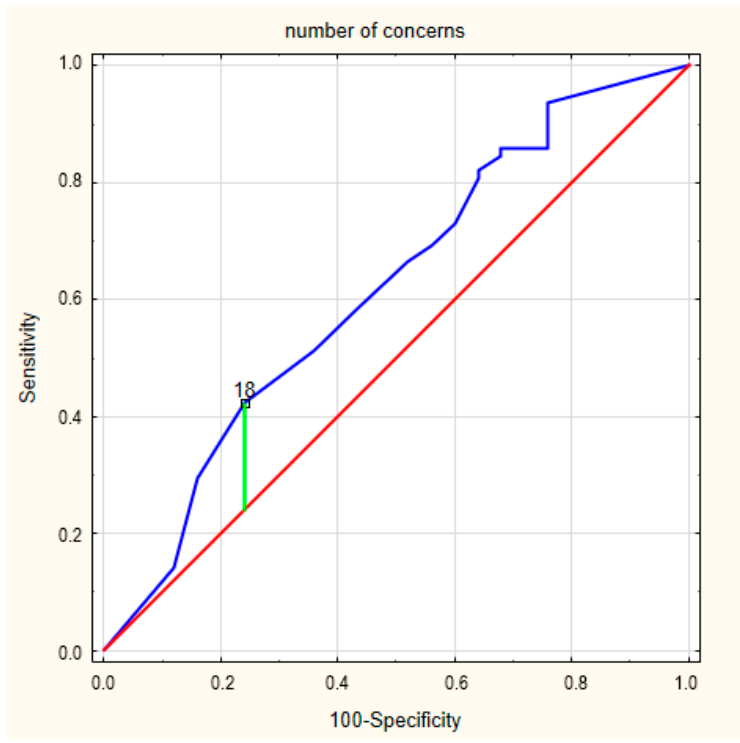
Figure 2. The ROC curves for the number of concerns in frailty syndrome.